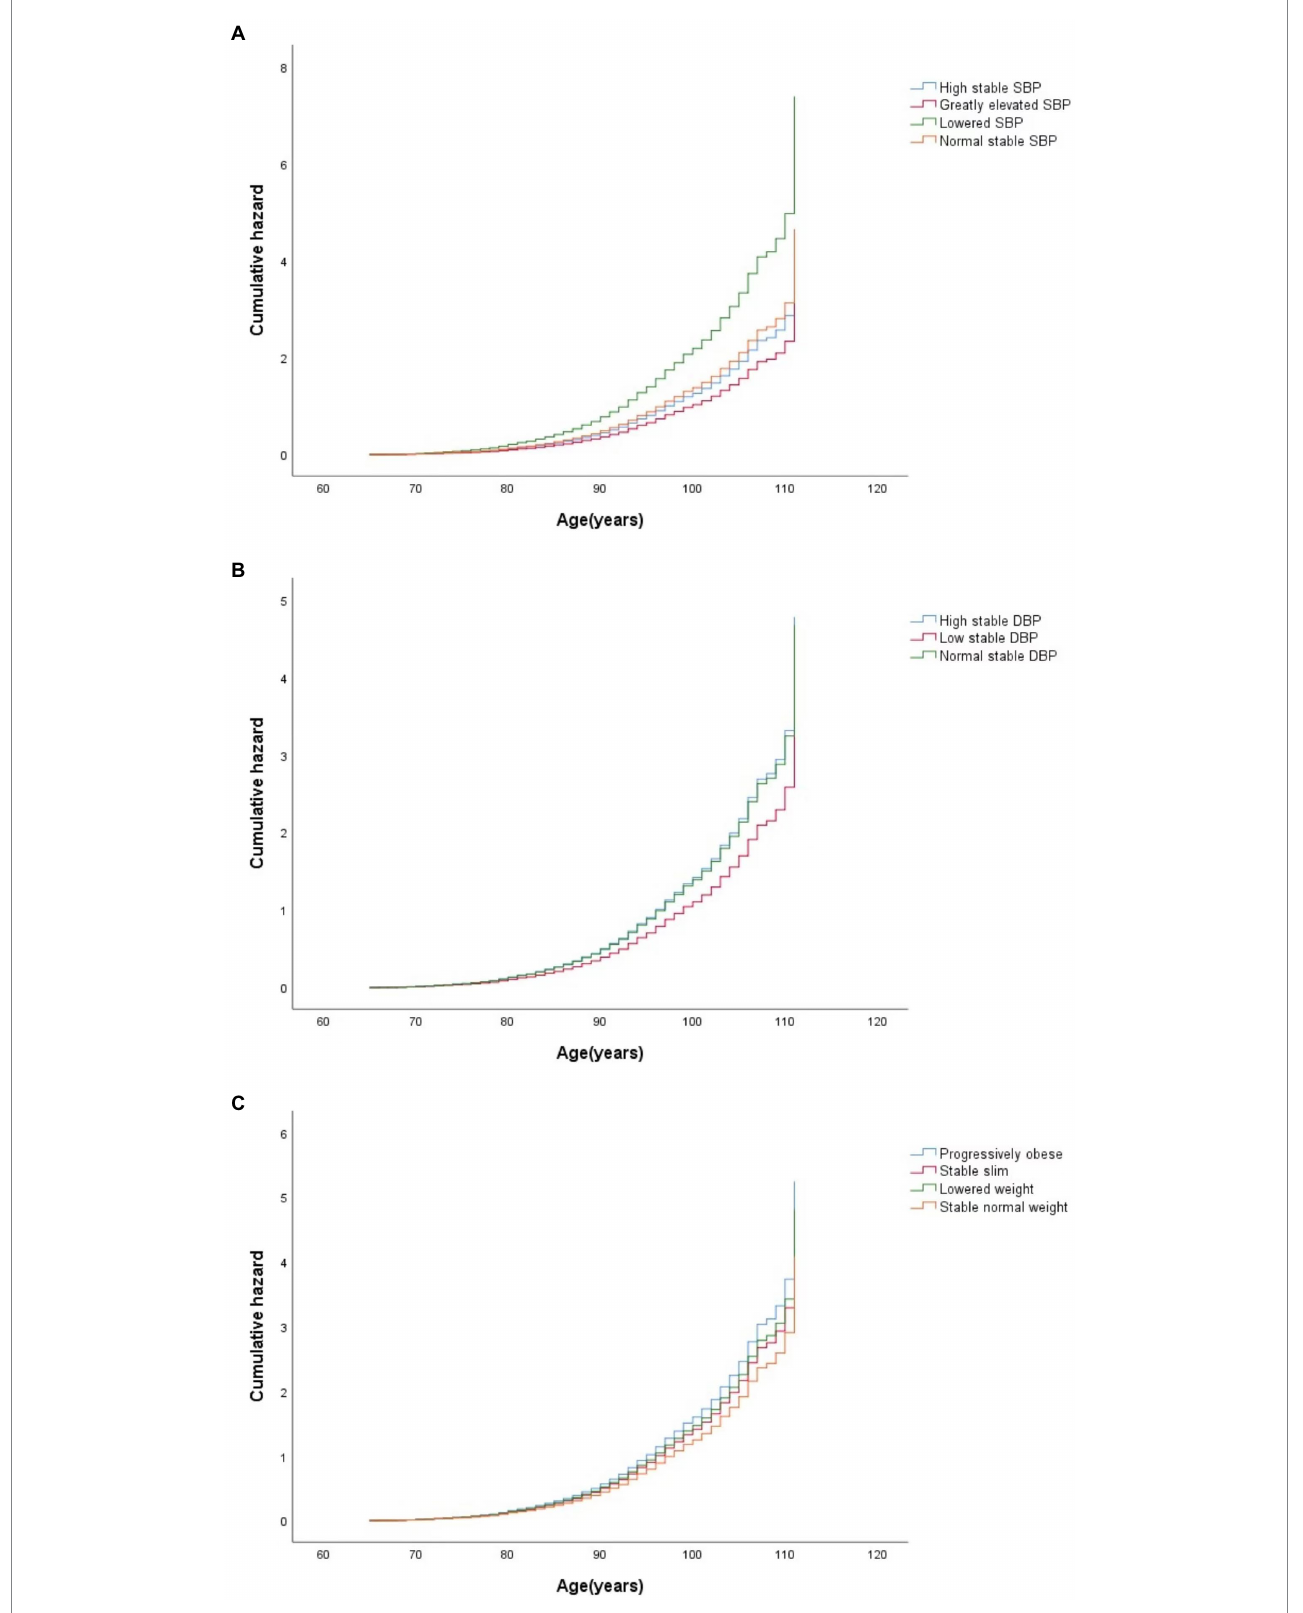
FIGURE 2 Curves of the cumulative hazard function of cognitive impairment by trajectory classes of SBP (A) , DBP (B) , and BMI (C) in the final adjusted model. SBP, systolic blood pressure; DBP, diastolic blood pressure; BMI, body mass